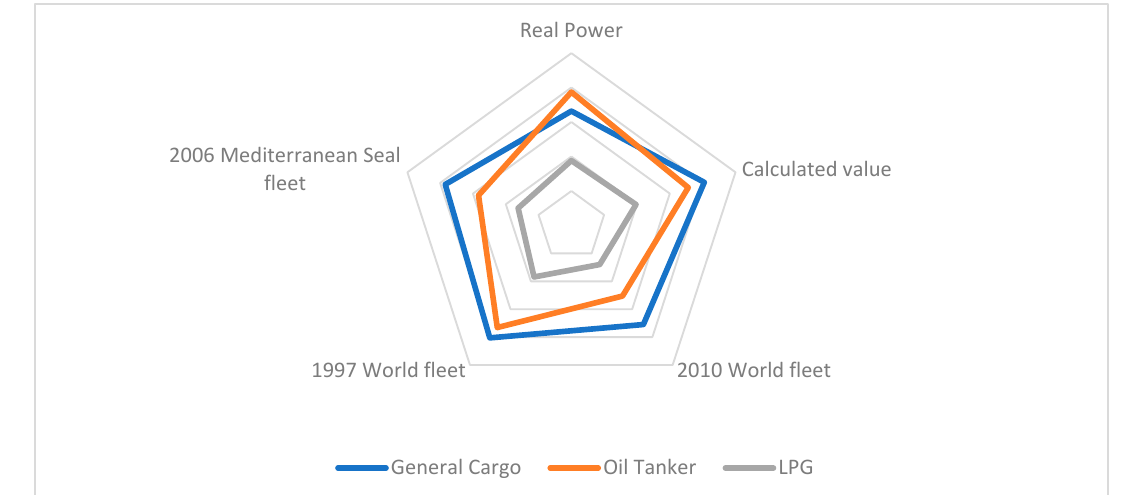
Table 9. Estimated average ship ratio of auxiliary engine/main engine by ship type.